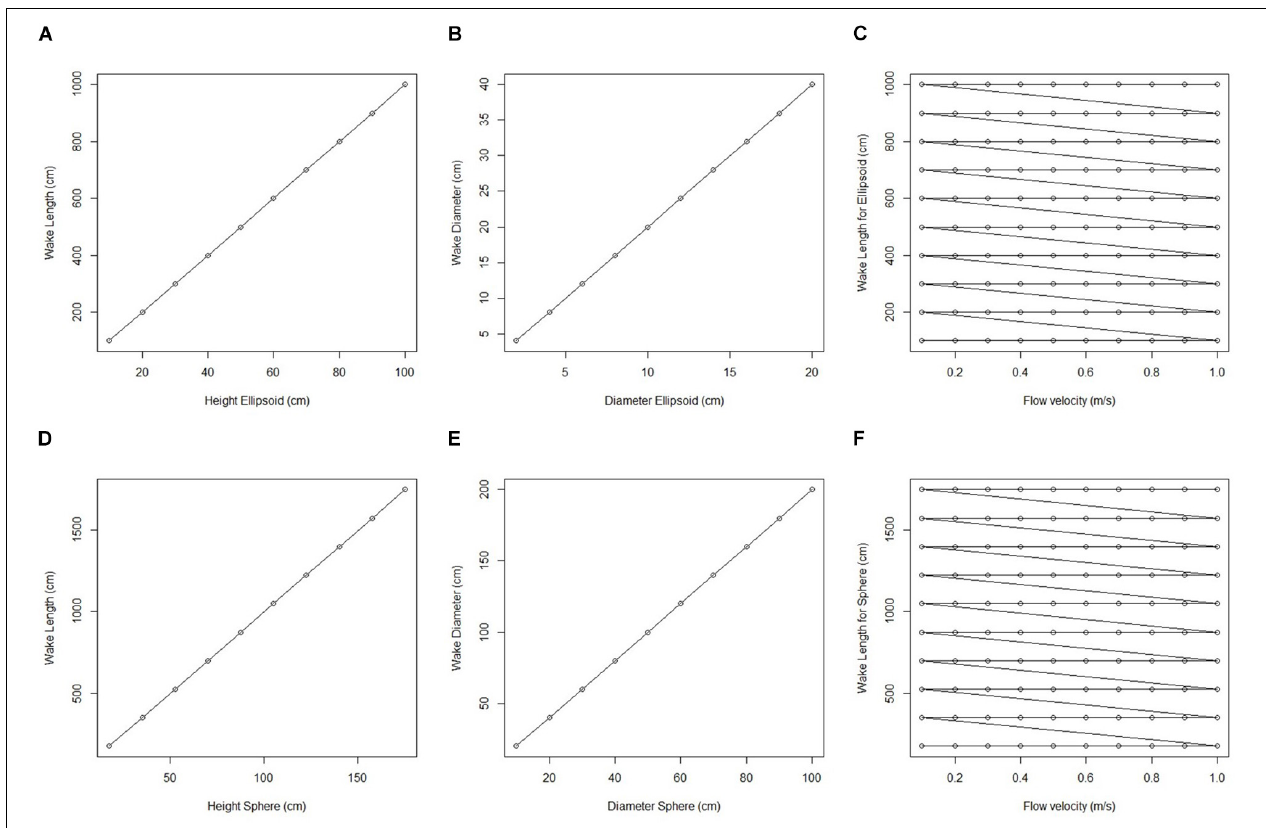
FIGURE 6 | Plots of wake dimension, object dimension and flow speed taken from fluid flow finite element analysis simulation for an idealized sphere and ellipsoid. (A) Wake length (cm) plotted against ellipsoid hight (cm). (B) Wake diameter (cm) plotted against ellipsoid diameter (cm). (C) Wake length for all ellipsoid simulations (cm) plotted against corresponding flow velocity (m/s). (D) Wake length (cm) plotted against sphere height (cm). (E) Wake diameter (cm) plotted against sphere diameter (cm). (F) Wake length for all sphere simulations (cm) plotted against corresponding flow velocity